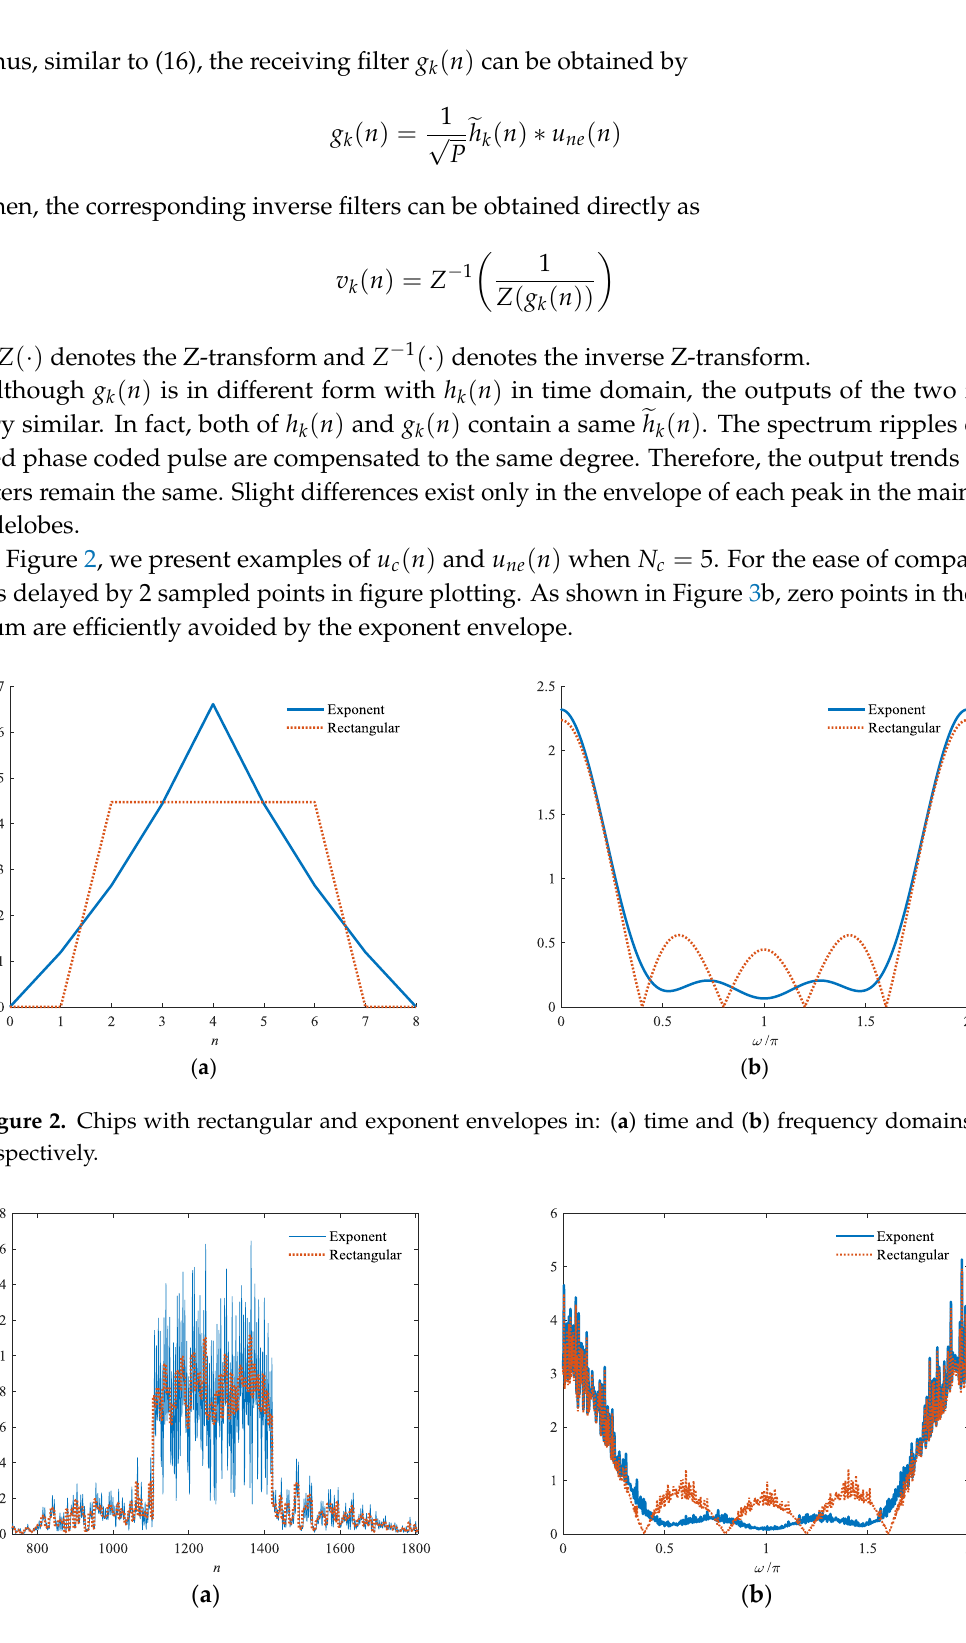
( a ) ( b ) Figure 4. Output of